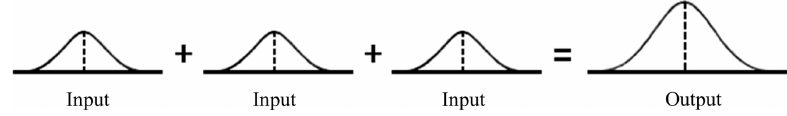
Figure 3. RSS method.